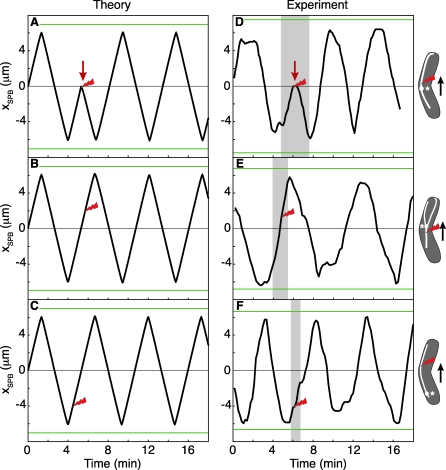
Comparison of Theory and Experiments: Oscillation Pattern after Microtubule Cutting(A–C) Numerical results and (D–F) experimental measurements of the SPB position as a function of time. The red bolt signs mark the time and the SPB position at the moment of microtubule cutting. Schemes show the SPB and the microtubules, as well as the site of laser ablation (bolt signs); the black arrows indicate the direction of SPB movement. Laser ablation of the leading microtubules induced a change of direction of the SPB movement (red arrows in [A and D]). In experiments, the change occurred within 25 ± 13 s after the ablation (mean ± standard deviation, n = 12).Laser ablation of the trailing microtubules (B, E) or the tip of the leading microtubules (C, F) did not perturb the SPB movement. The parameters in (A–C) are as in Figure 4, except υ0 = 5 μm/min, υs = −5 μm/min, and υg = 3 μm/min corresponding to the strain SV28xSV31 (Text S1, Table SIII).The gray rectangles in (D–F) mark the time interval of the images shown in Figures 1B–1D; the green lines mark the cell ends.